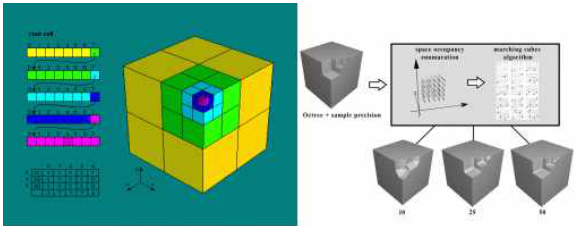
Figure 7. Applying the Octree Algorithm (data source: MPSS, 2015-1)